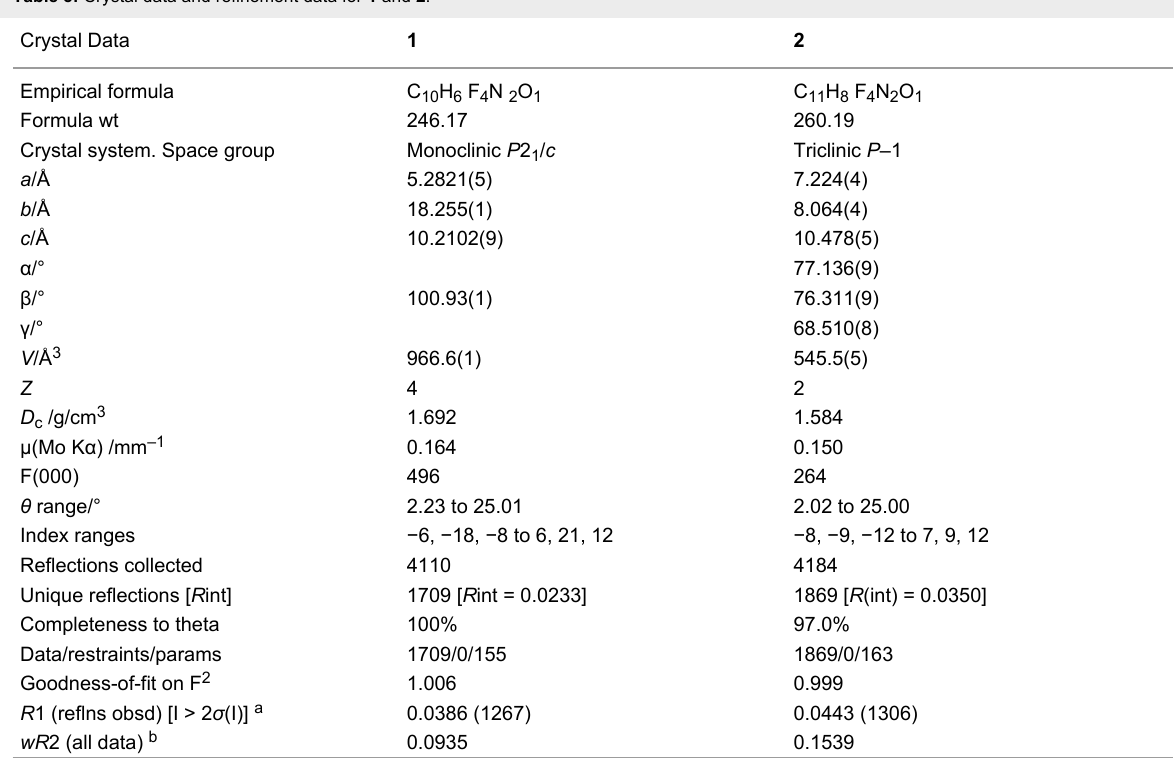
Table 5: Crystal data and refinement data for 1 and 2